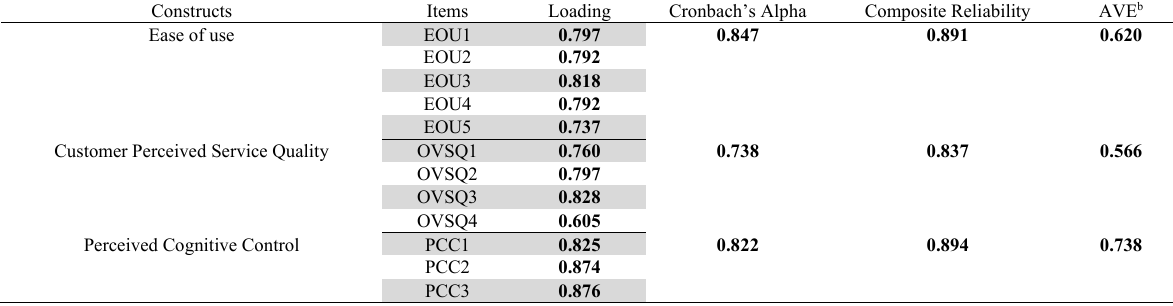
Convergent Validity of Constructs